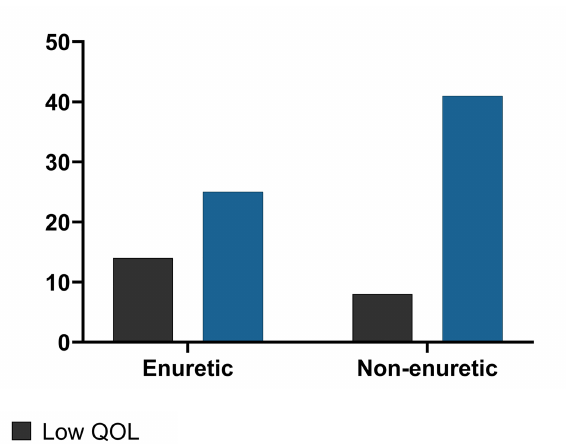
Figure 1 - Quality of Life in enuretic children compared to non-enuretic ones